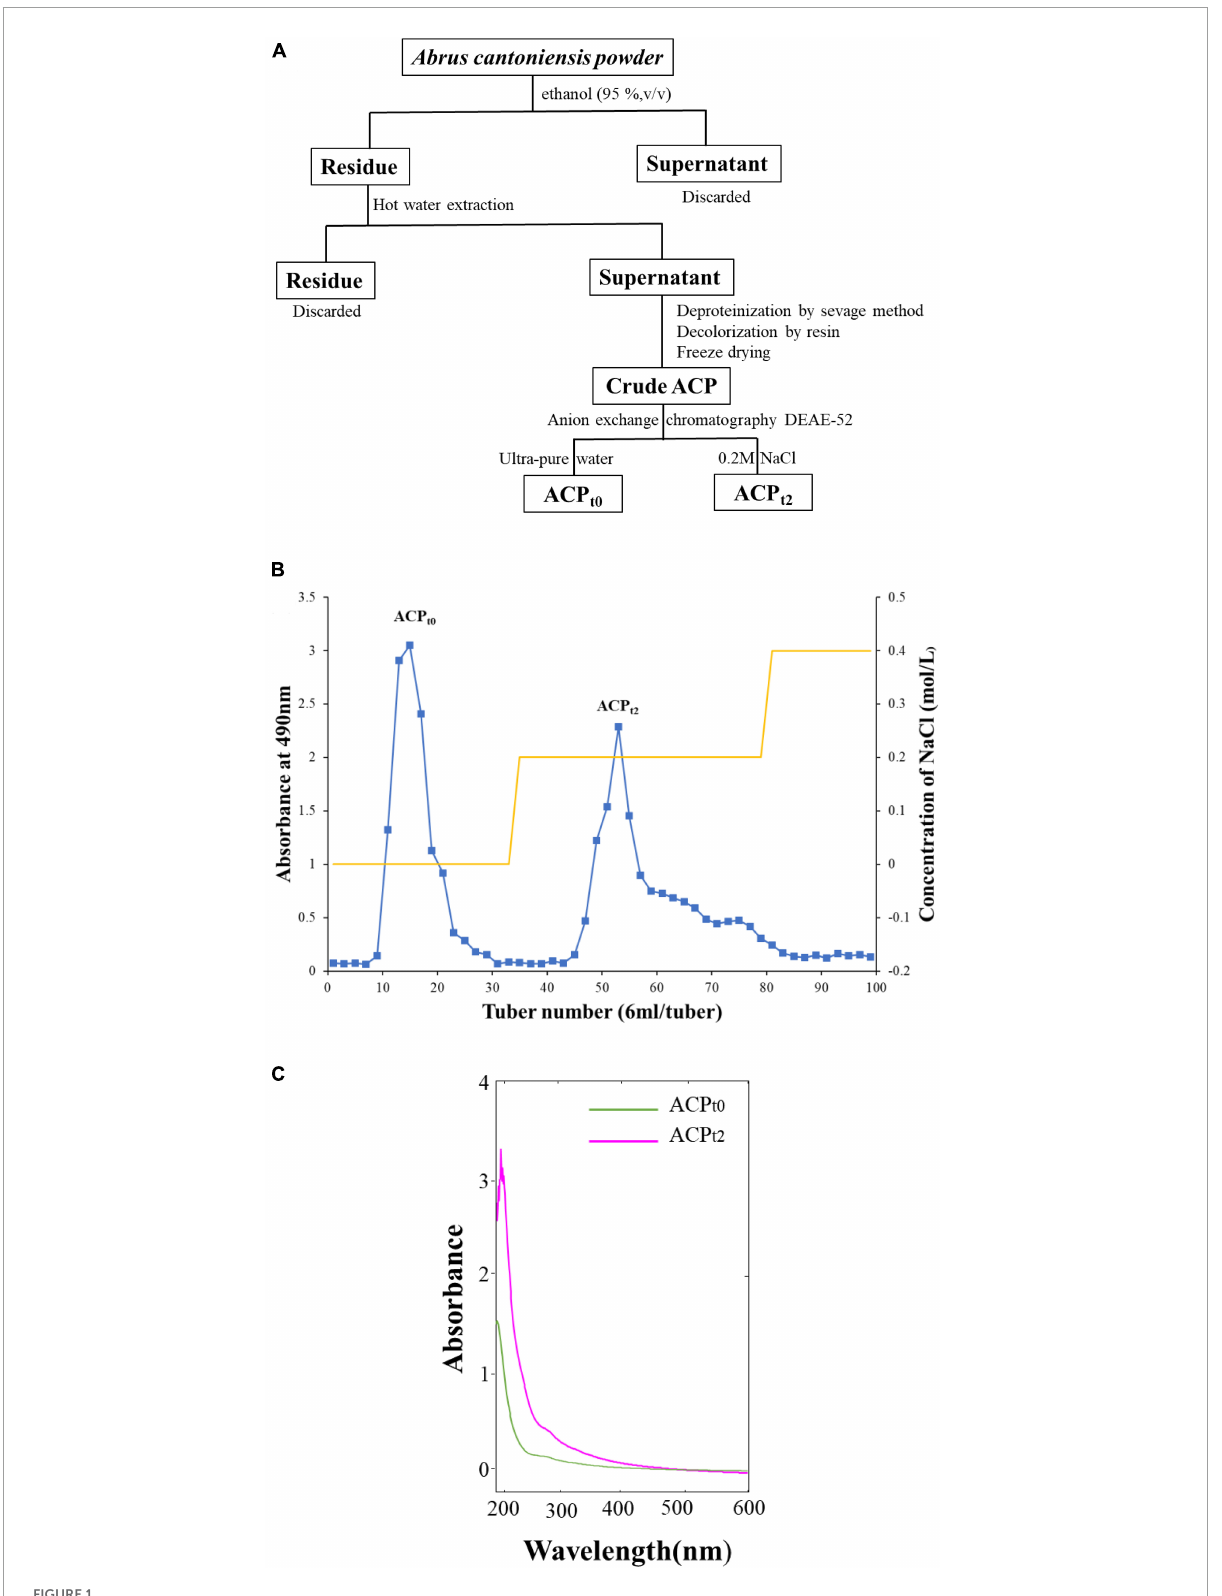
FIGURE1 (A) The process of separation and purification of ACP. (B) Chromatography of crude ACP by DEAE-52 cellulose chromatography column. (C) UV spectrum of ACP t 0 and ACP t 2